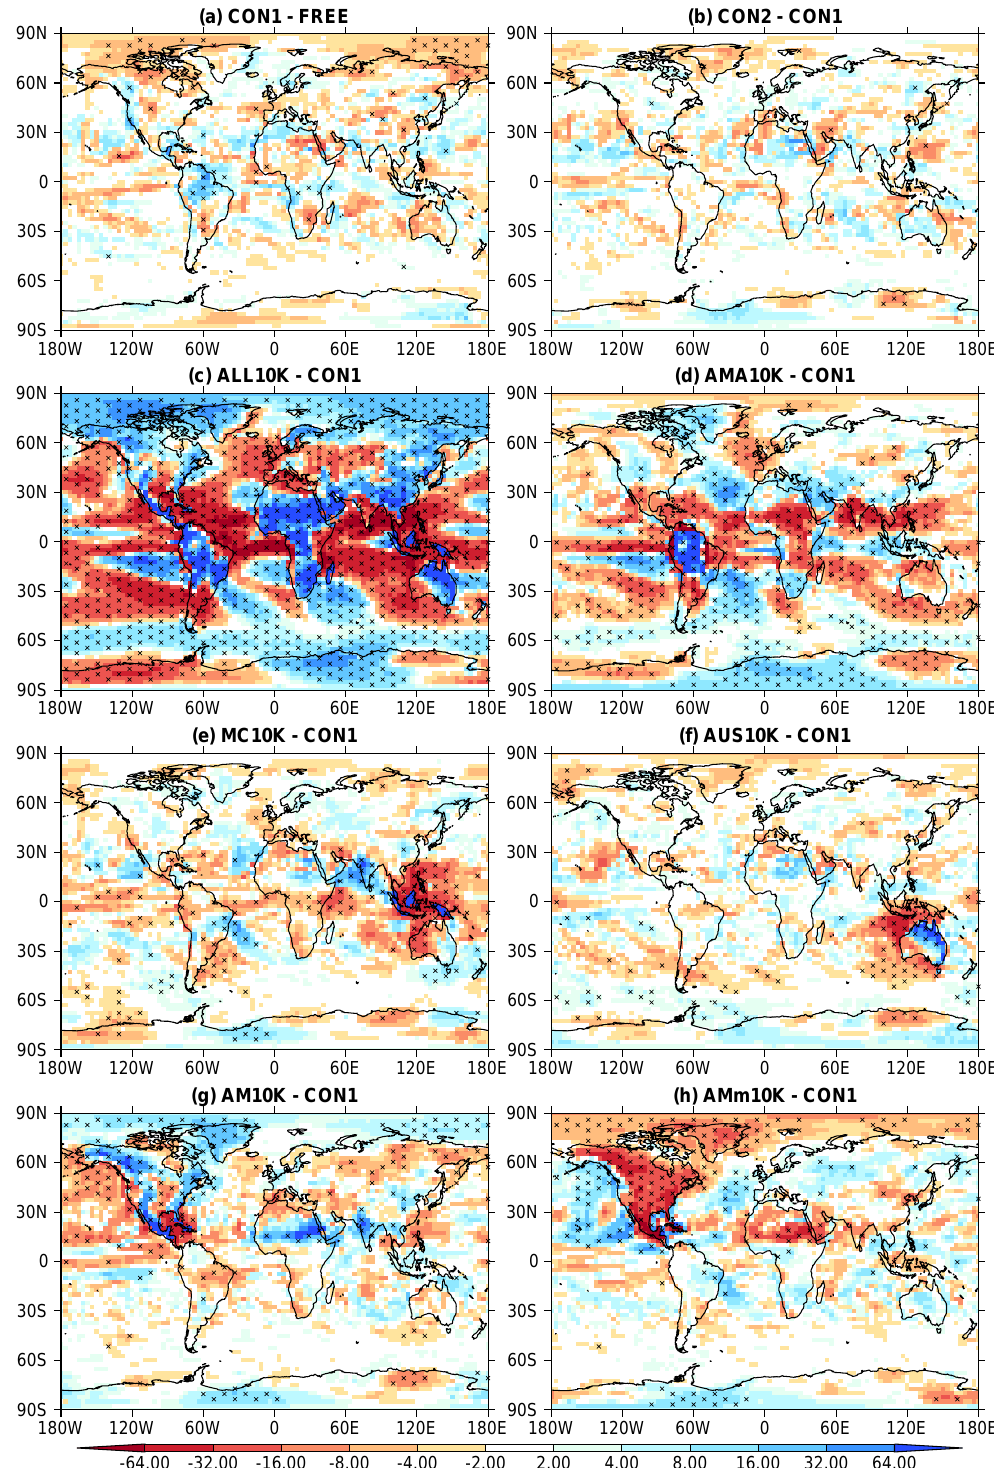
Figure 4. Differences in annual mean precipitation (%) for (a) CON1 – FREE, (b) CON2 – CON1, (c) ALL10K – CON1, (d) AMA10K – CON1, (e) MC10K – CON1, (f) AUS10K – CON1, (g) AM10K – CON1, and (h) AMm10K – CON1. Values of p ≤ 0.05 are denoted with an